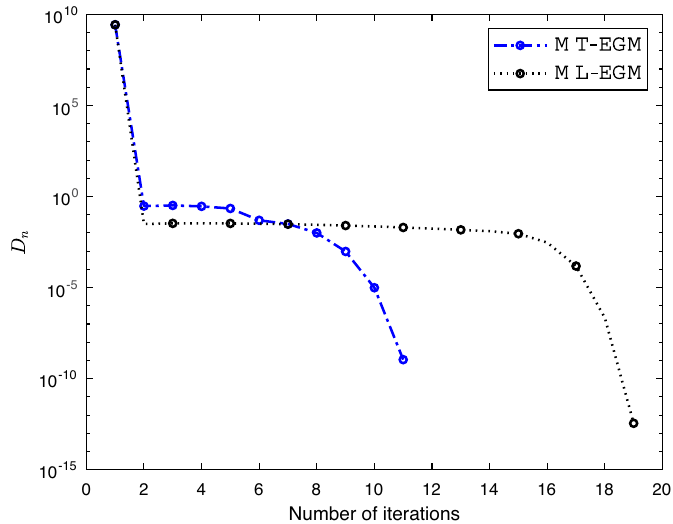
Figure 8: Numerical illustration of Algorithms 1 and 2 while u 1, 2, …,1,000, 0, 0, … 0 ( ) =